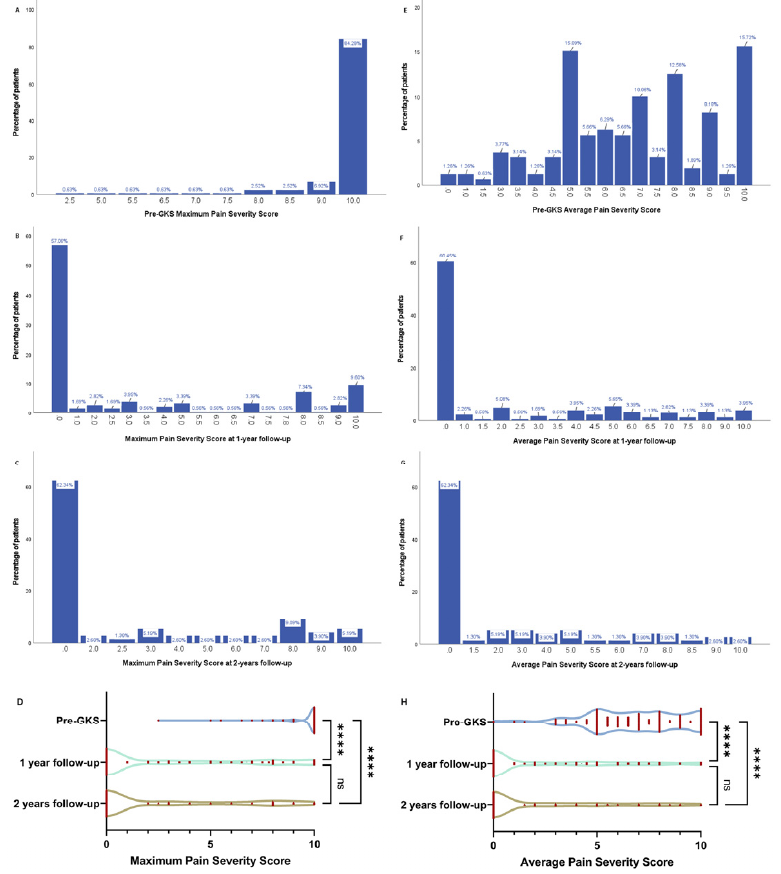
Figure 4. Pain severity before GKSRS, and at the 1-year and 2 years follow-up assessments, displaying the maximum ( A – D ) and average pain severity scores ( E – H ). ns: not significant, **** p < 0.0001.